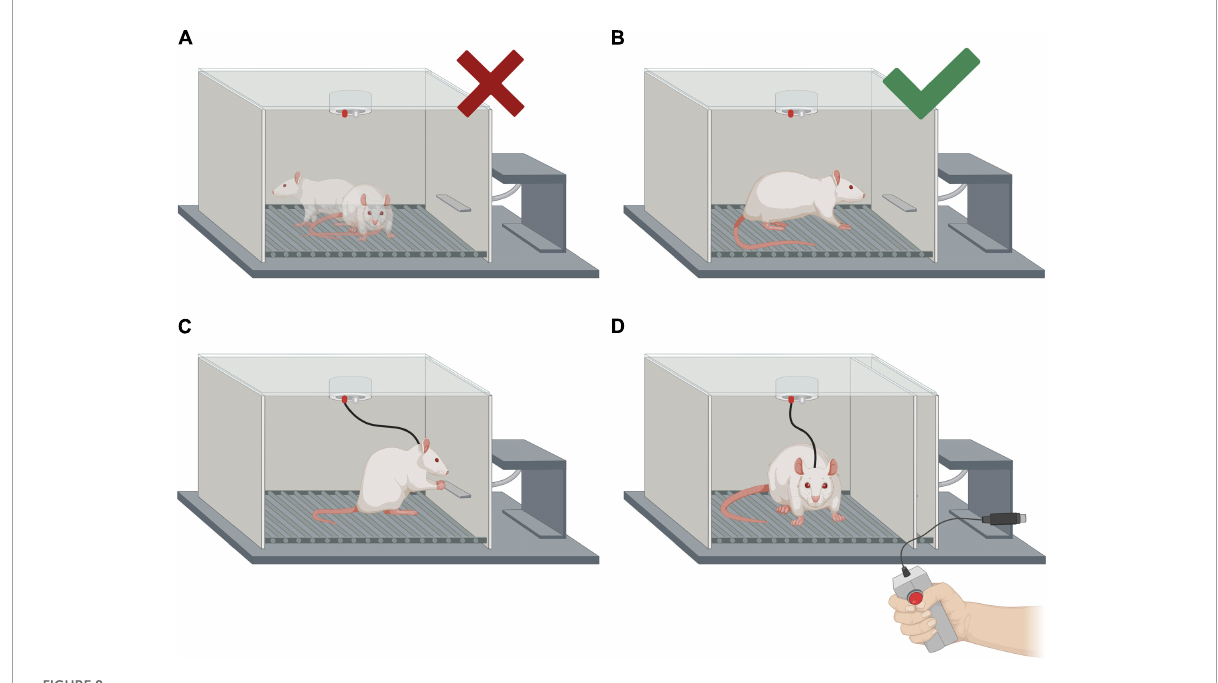
FIGURE8 Intracranial electrical self-stimulation (ICSS) behavior shaping and representation of the two forms of treatment administration (self-administered and experimenter-administered). (A) Examples of the animal’s positions in which no manual stimulation should be administered. (B) Position of the rat in which manual stimulation should be administered in order to make the animal approach the lever. Please note that the electrode connections are not shown. (C) Self-administration of the treatment (ICSS). (D) Experimenter-administered treatment (EAS). The same apparatus is used for ICSS and EAS, but the lever must be hidden for the EAS